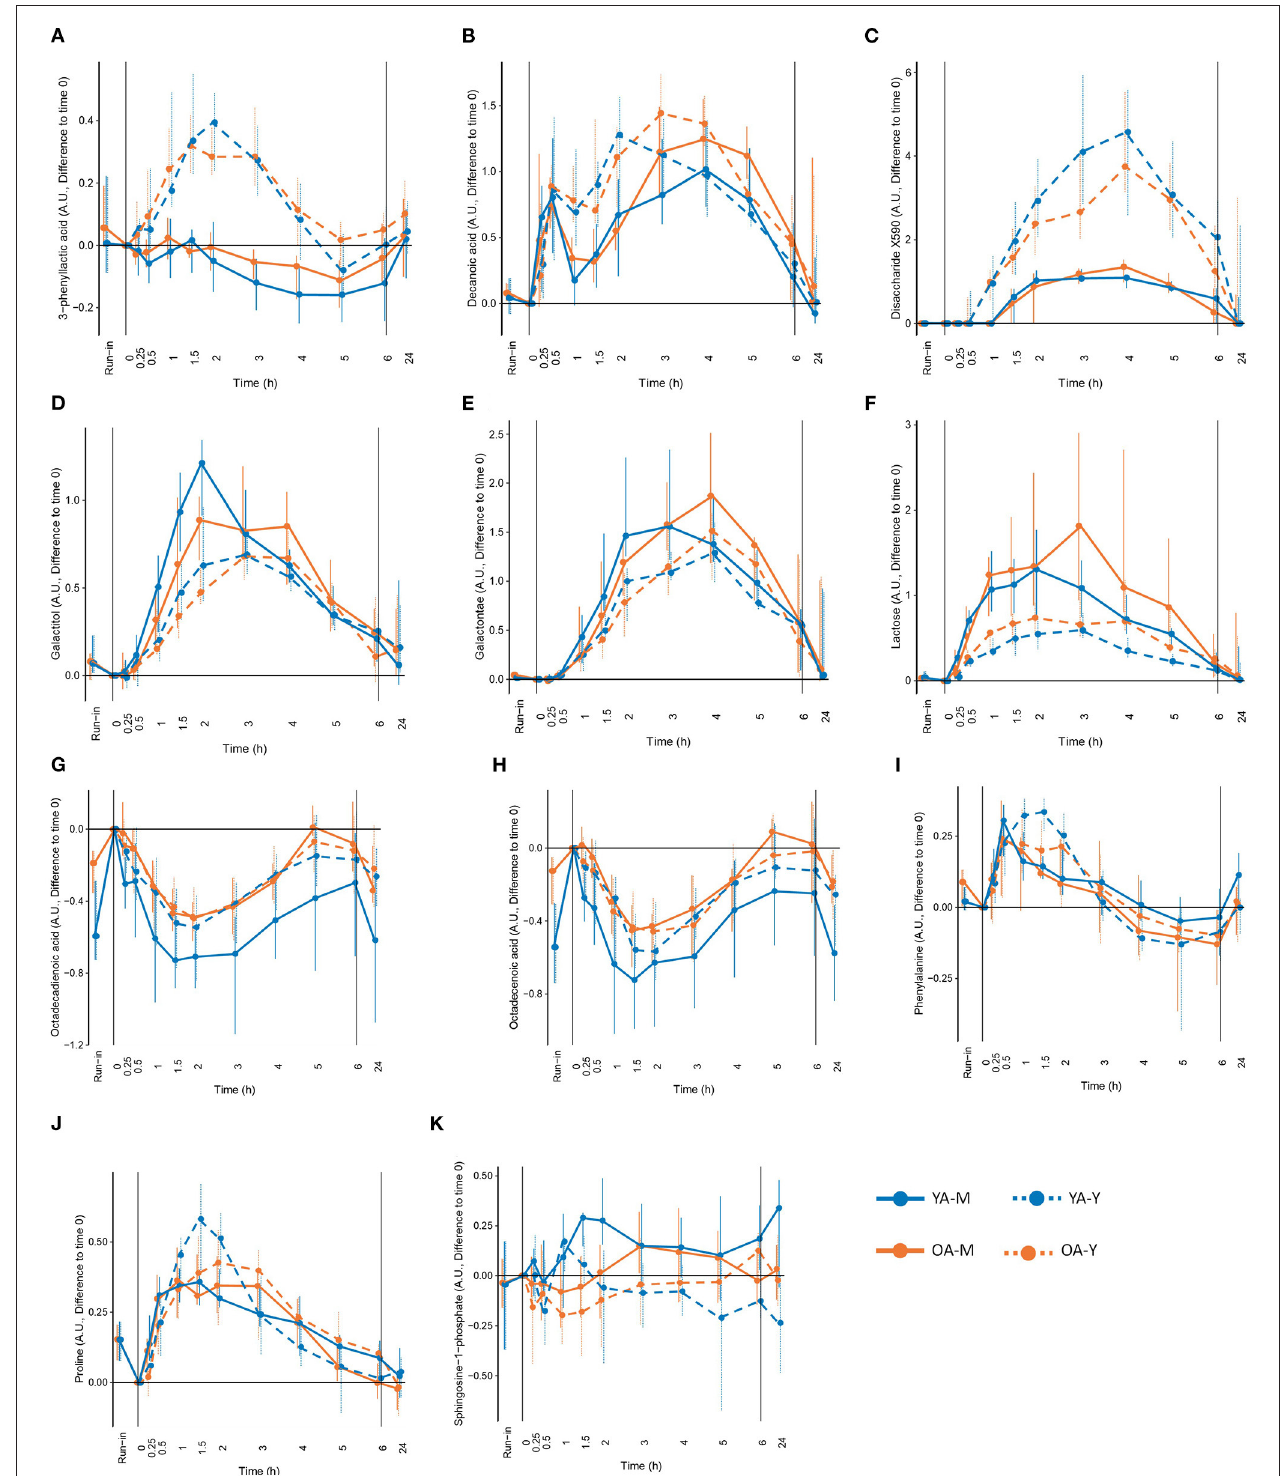
FIGURE 4 | Selected metabolites that could be interesting as candidate biomarkers of the intake of milk (M), yogurt (Y), or dairy in the young (YA) and the older (OA) men, based on the significant modification during the exclusion of dairy intake (run-in), different concentration in milk and yogurt, significant differences in postprandial responses between milk and yogurt intake, and modification in fasting levels after 24h of dairy intake. (A) 3-phenyllactic acid, (B) decanoic acid, (C) disaccharide X590, (D) galactitol, (E) galactonate, (F) lactose, (G) octadecadienoic acid, (H) octadecenoic acid, (I) phenylalanine, (J) roline, and (K) sphingosine-1-phhosphate. See Table 1 for detailed information on differences following the run-in period and 24h following the dairy intake.